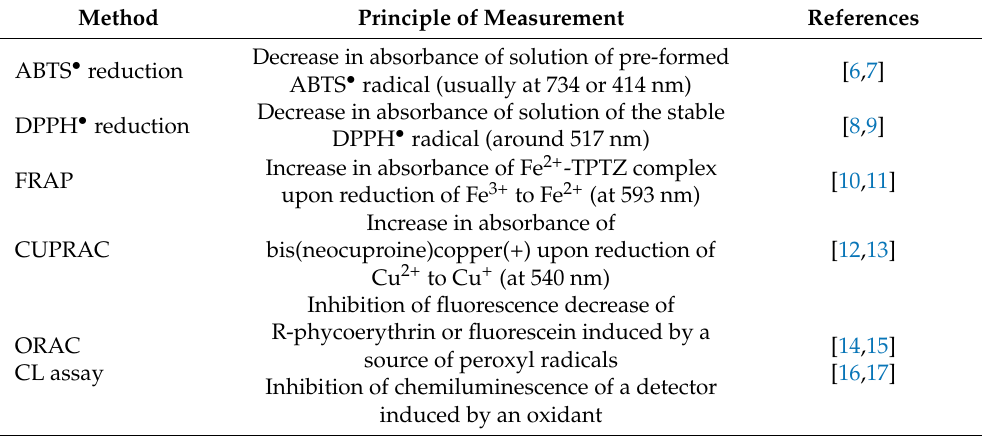
Table 1. Most popular assays of total antioxidant